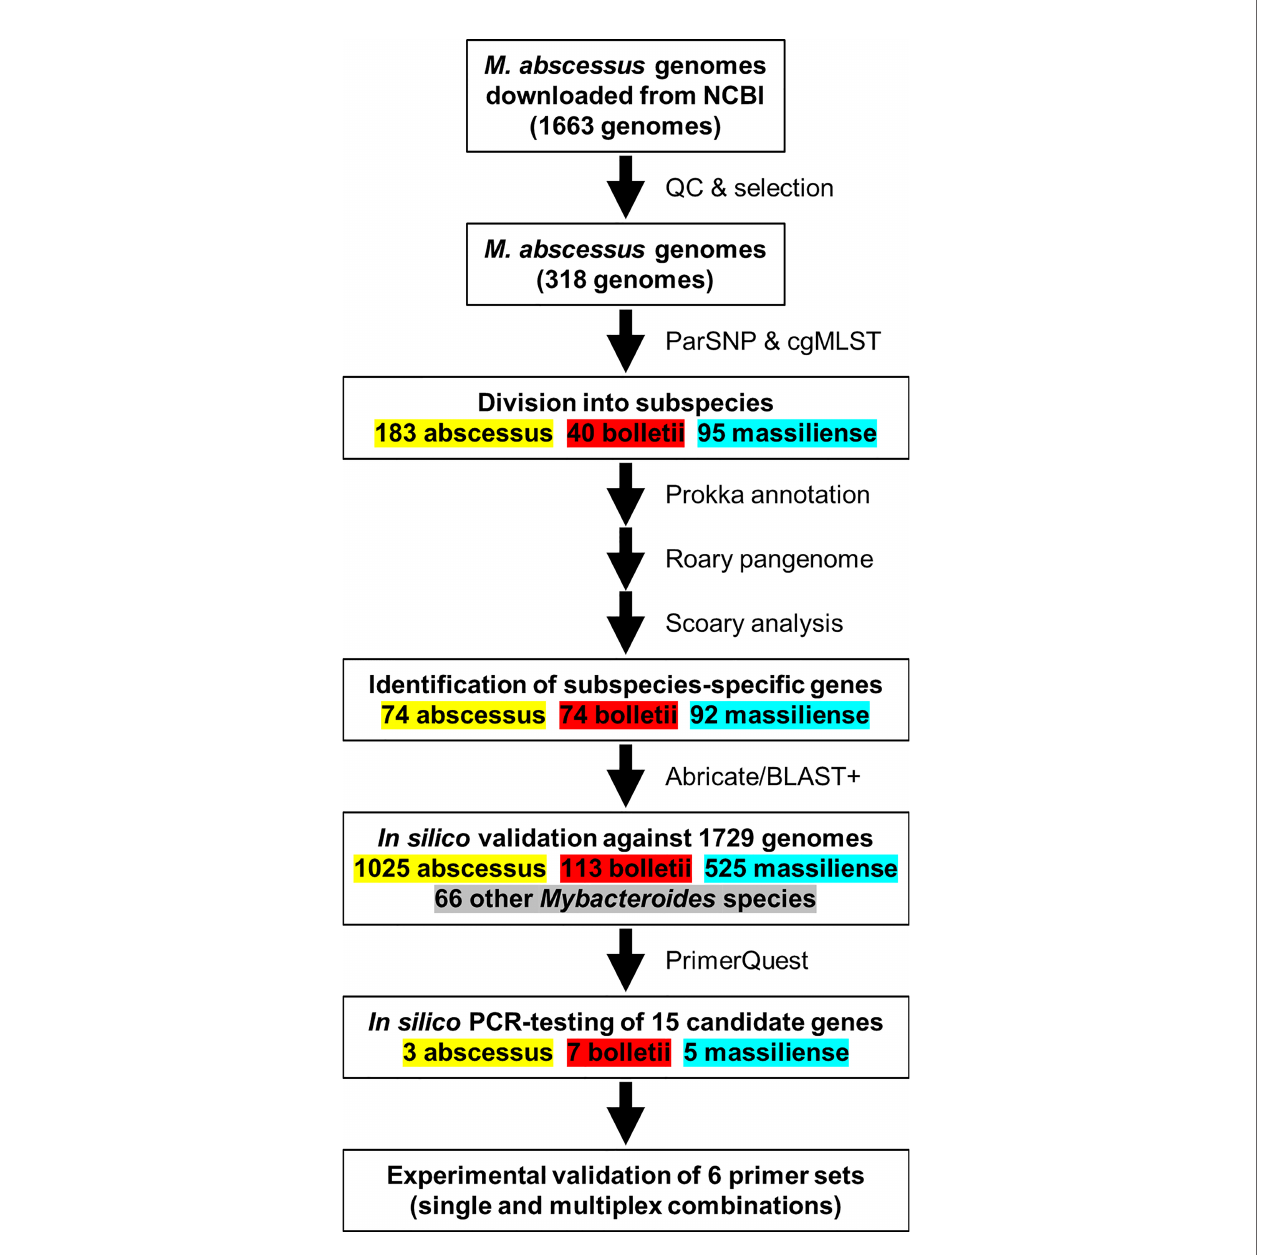
FIGURE 1 | An overview of the work fl ow used to identify M. abscessus genomes for the in-silico evaluation of the PCR primers